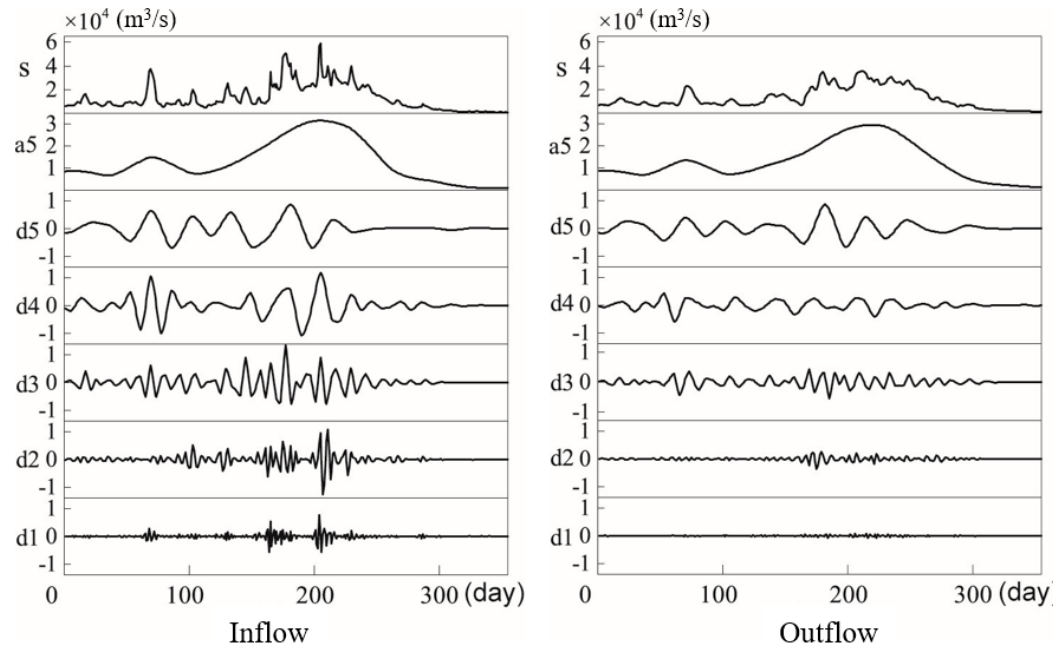
Figure 2. The wavelet decomposition of different frequency fluctuations for inflow and outflow of the lake. S is the original flow series, d1 to d5, and a5 represents the decomposition of 2, 4, 8, 16, 32, and 64 days.